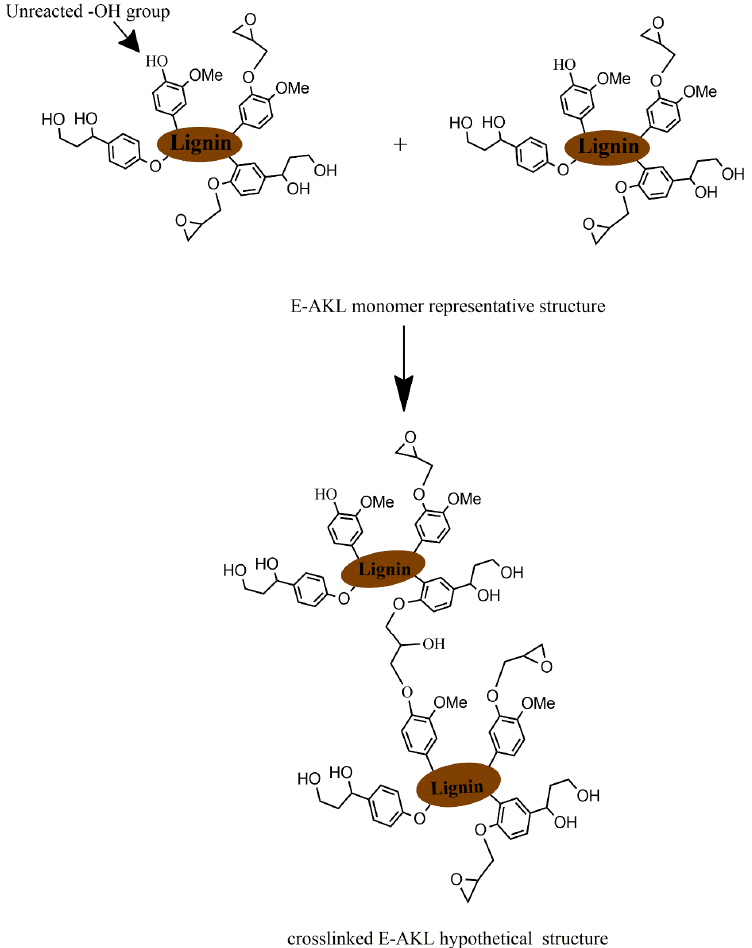
Figure 5. Schematic of the possible cross-linking reaction between remaining lignin -OH moieties and the inserted epoxy groups.